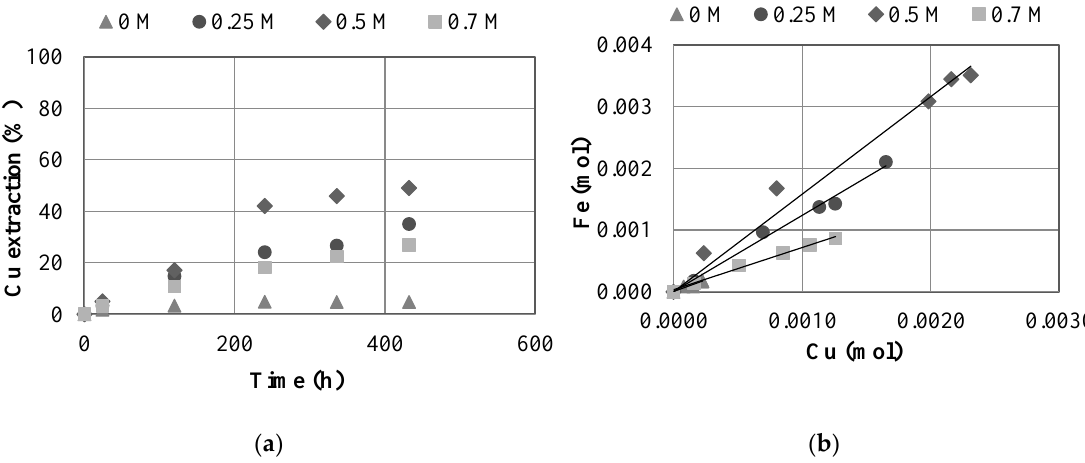
Figure 5. ( a ) Copper extraction (%) versus time (h) at different sodium nitrate concentration: 0, 0.25, 0.5 and 0.7 M. ( b ) Cu/Fe molar ratio at different sodium nitrate concentration: 0, 0.25, 0.5 and 0.7 M. Experimental conditions: [H 2 SO 4 ] = 0.7 M, seawater as dissolvent, −150 + 75 µm, S/L ratio 2 g/L, 45 °C, 350 rpm, sample A.